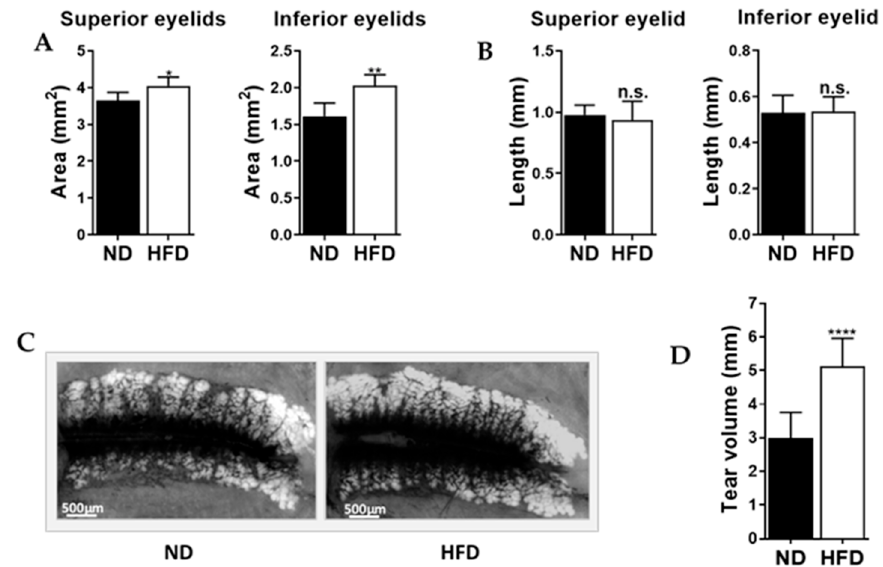
Figure 3. HFD mice showed ( A ) larger meibomian gland area and ( B ) similar meibomian gland length. ( C ) Representative meibographs showing a typical set of glands from an ND mouse and an HFD mouse. ( D ) HFD mice also showed greater tear volume than ND mice. All data are expressed as means ± SD. * p < 0.05, ** p < 0.01, **** p < 0.0001, n.s. = not significant. Asterisks indicate a significant difference compared to the matched ND value.